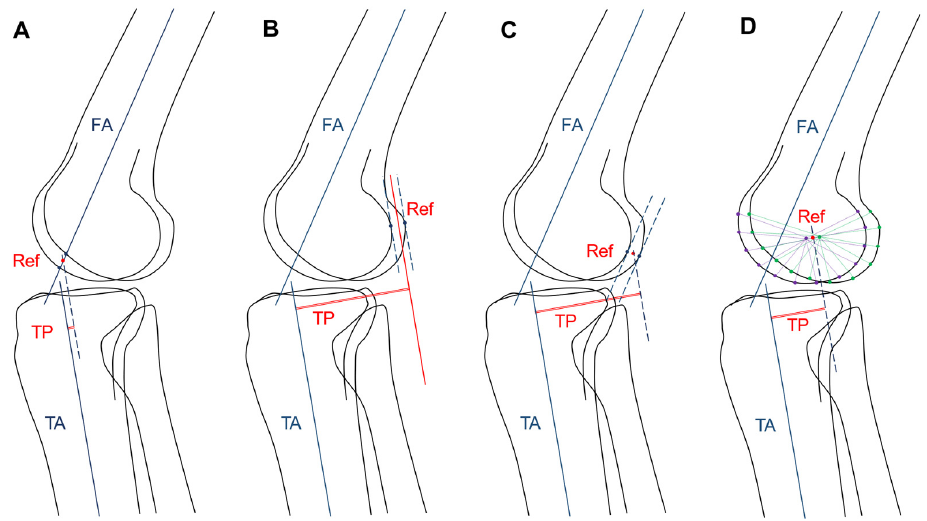
Figure 4. Four measurement methods. The femoral axis (FA) and the tibial axis (TA) were drawn first. ( A ) In method 1, the midpoint of the intersection points of the femoral axis and the femoral condylar edges was the femoral reference point (Ref). ( B ) In method 2, the midline of the lines tangential to posterior femoral condylar edges and parallel to TA was the femoral reference line (Ref). ( C ) In method 3, the midpoint of the tangent points of the lines tangential to posterior femoral condylar edges and parallel to FA was the femoral reference point (Ref). ( D ) In method 4, the midpoint of the center points of the medial and lateral femoral condyle landmarks was the femoral reference point (Ref). Finally, in all four methods, the distance between the TA and Reference was the tibial position